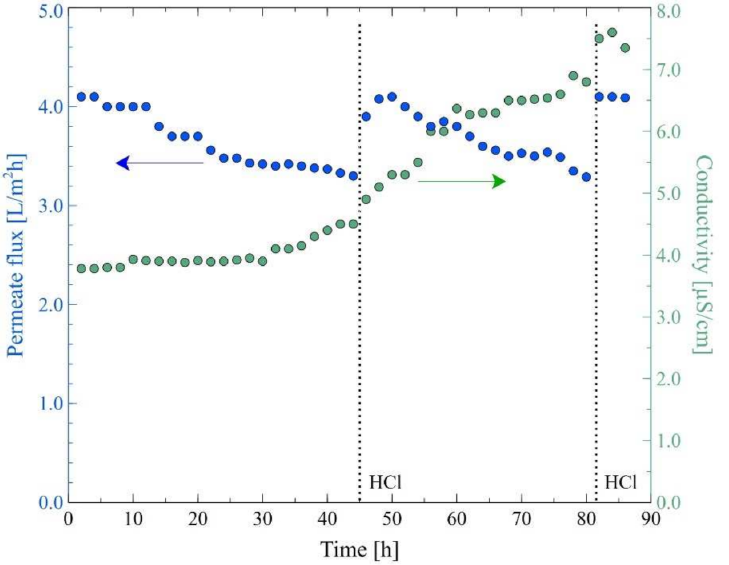
Figure 9. Changes in the permeate flux and distillate conductivity. Feed: the Baltic Seawater, T F = 343 K, v F = 0.12 m/s. Module M2. A 45 h and 82 h of the MD process run—the module rinsing with 3% HCl